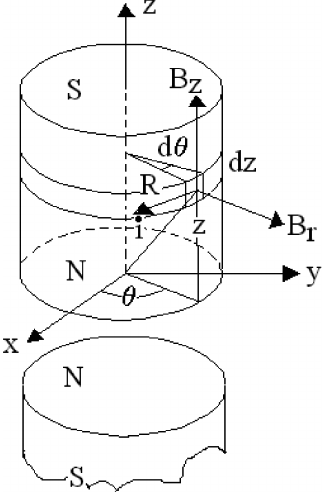
Fig. 3. Magnetic fl ux density due to one permanent magnet at the surface of the second